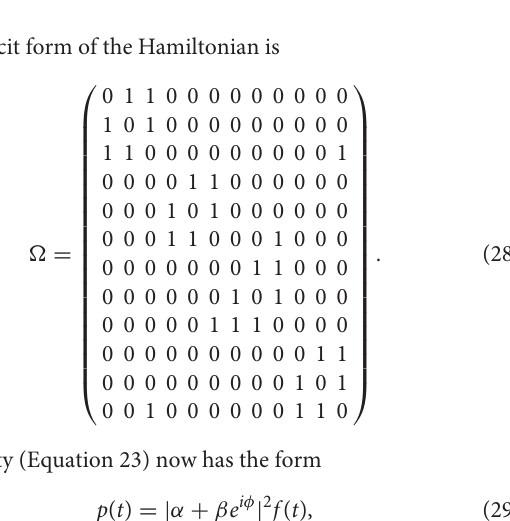
FIGURE 7 | The three time-dependent functions occurring in Equation (24) for t 0 200: A ( t ) (black), B ( t ) (red), C ( t ) (blue). The blue curve is a measure of ≤ ≤ self-interference in